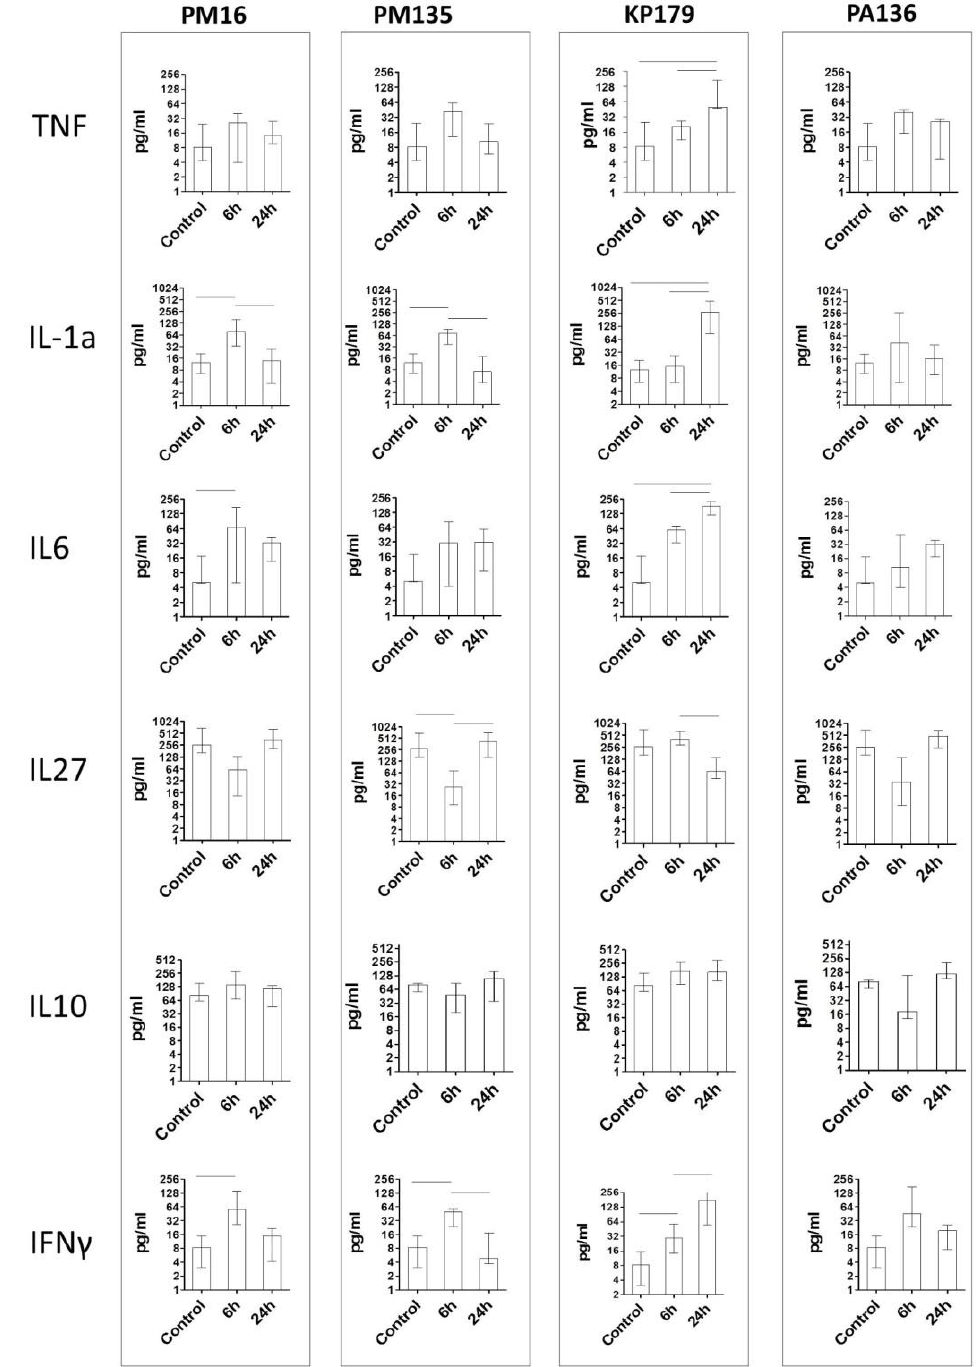
Figure 3. Cytokine concentration in plasma of mice once administered an intraperitoneal injection of the phages at a target dose of 10 8 PFU per mouse in 100 μL 0.9% NaCl. Control indicates injection of 100 μL 0.9% NaCl. Cytokine concentrations were evaluated six and 24 h after phage injection. Results are given in medians with interquartile range. Horizontal lines indicate statistical significance, p < 0.05.